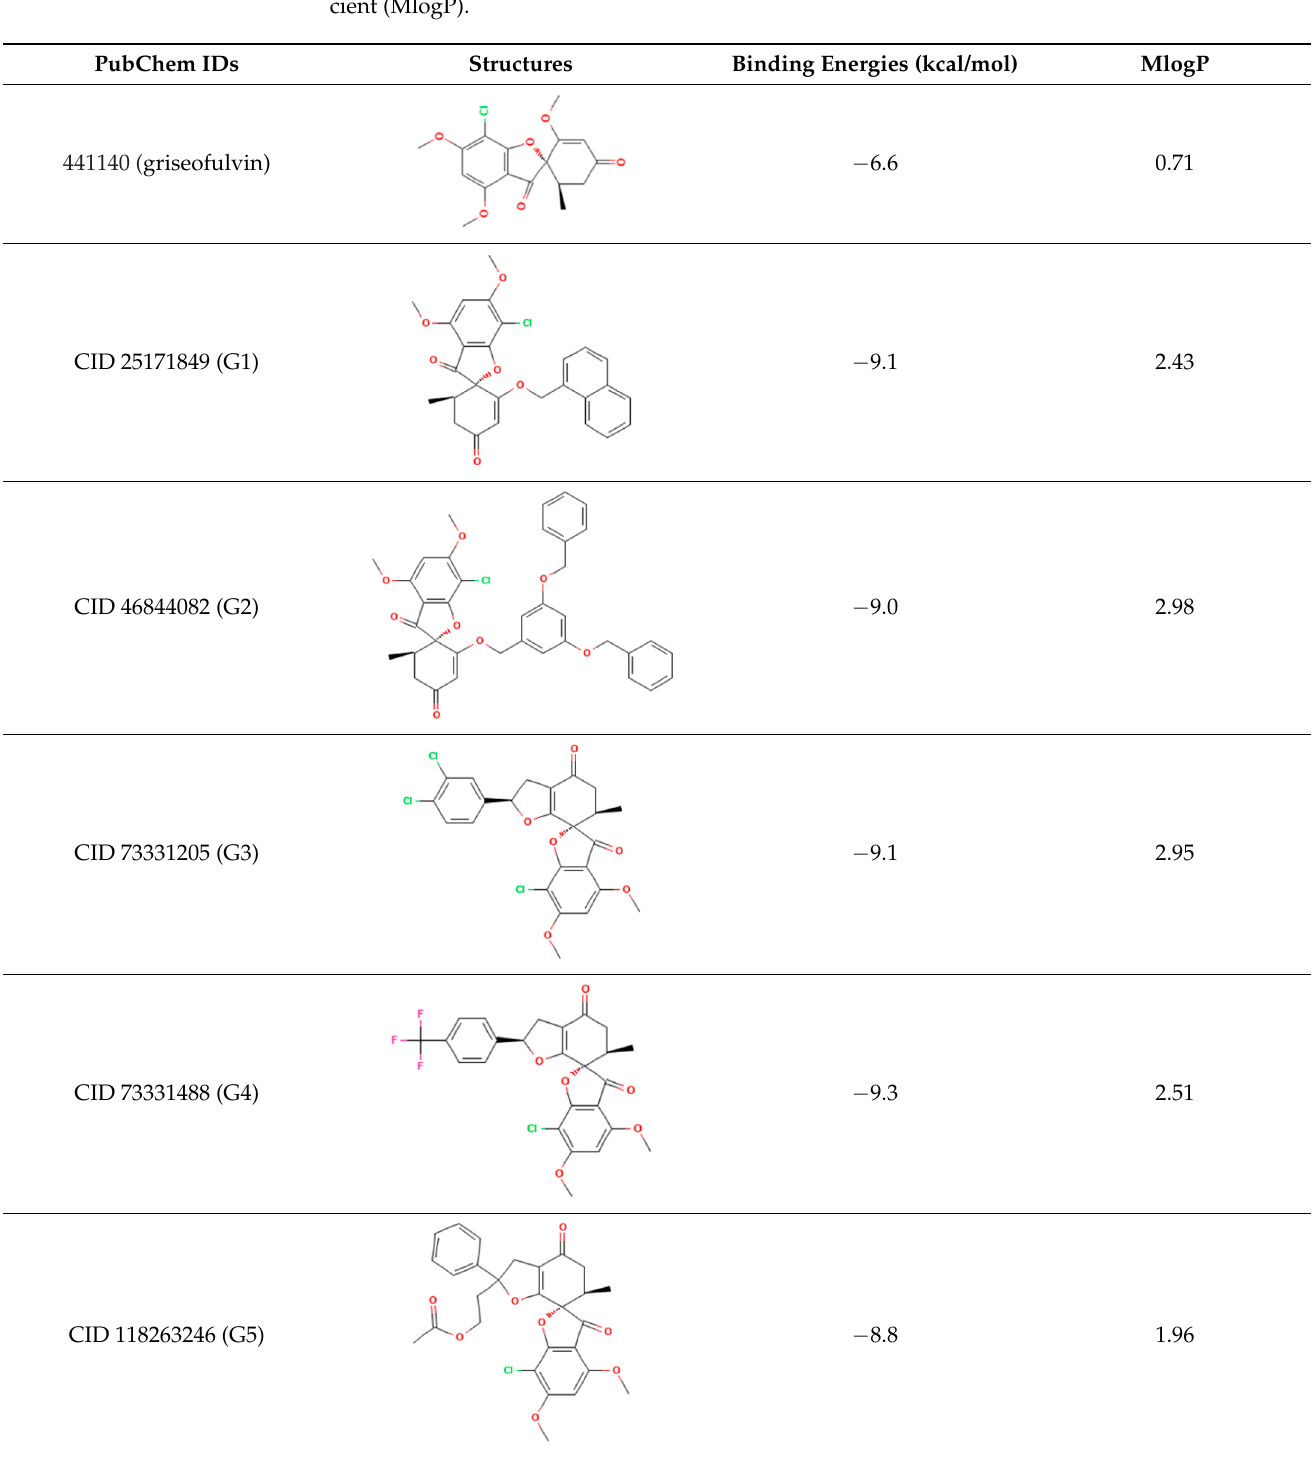
Table 1. Chemical two-dimensional (2D) structures of selected derivatives as well as computed binding energies towards TUBB5, and also estimated Moriguchi octanol-water partition coefficient (MlogP).